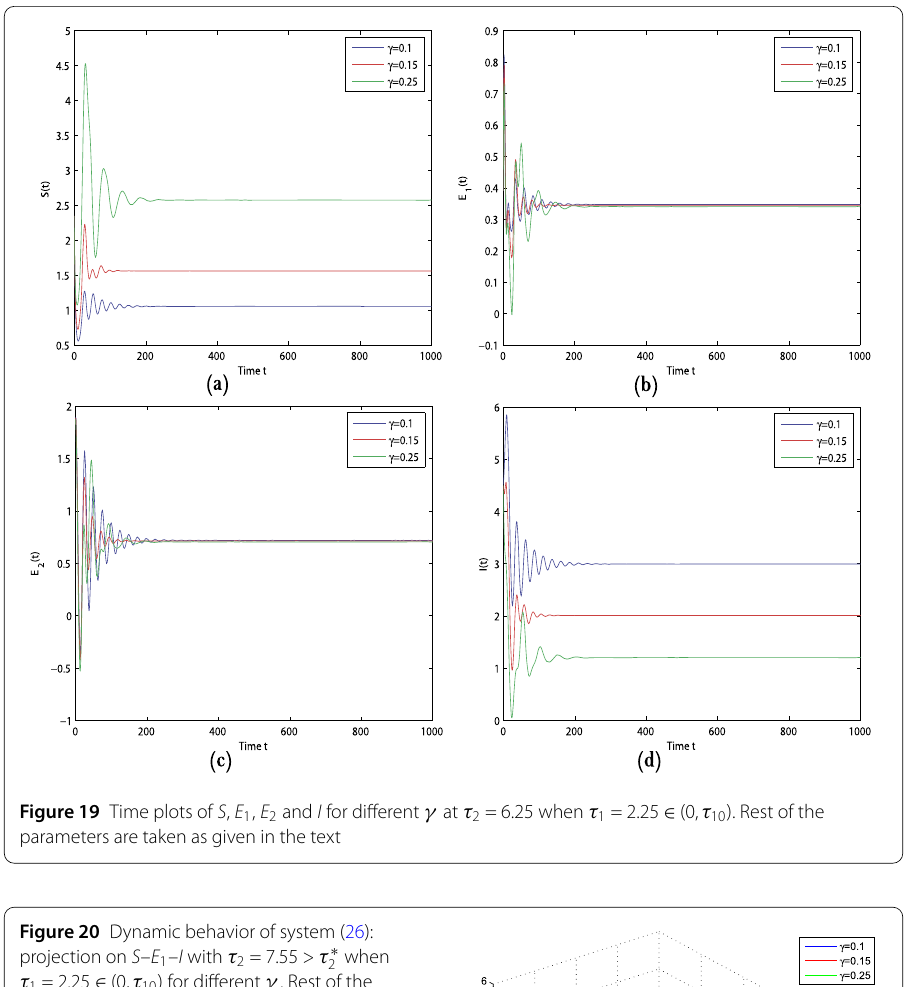
Figure 20 Dynamic behavior of system (26): projection on S – E 1 – I with τ 2 = 7.55 > τ ∗ 2 when τ 1 = 2.25 ∈ (0, τ 10 ) for different γ . Rest of the parameters are taken as given in the